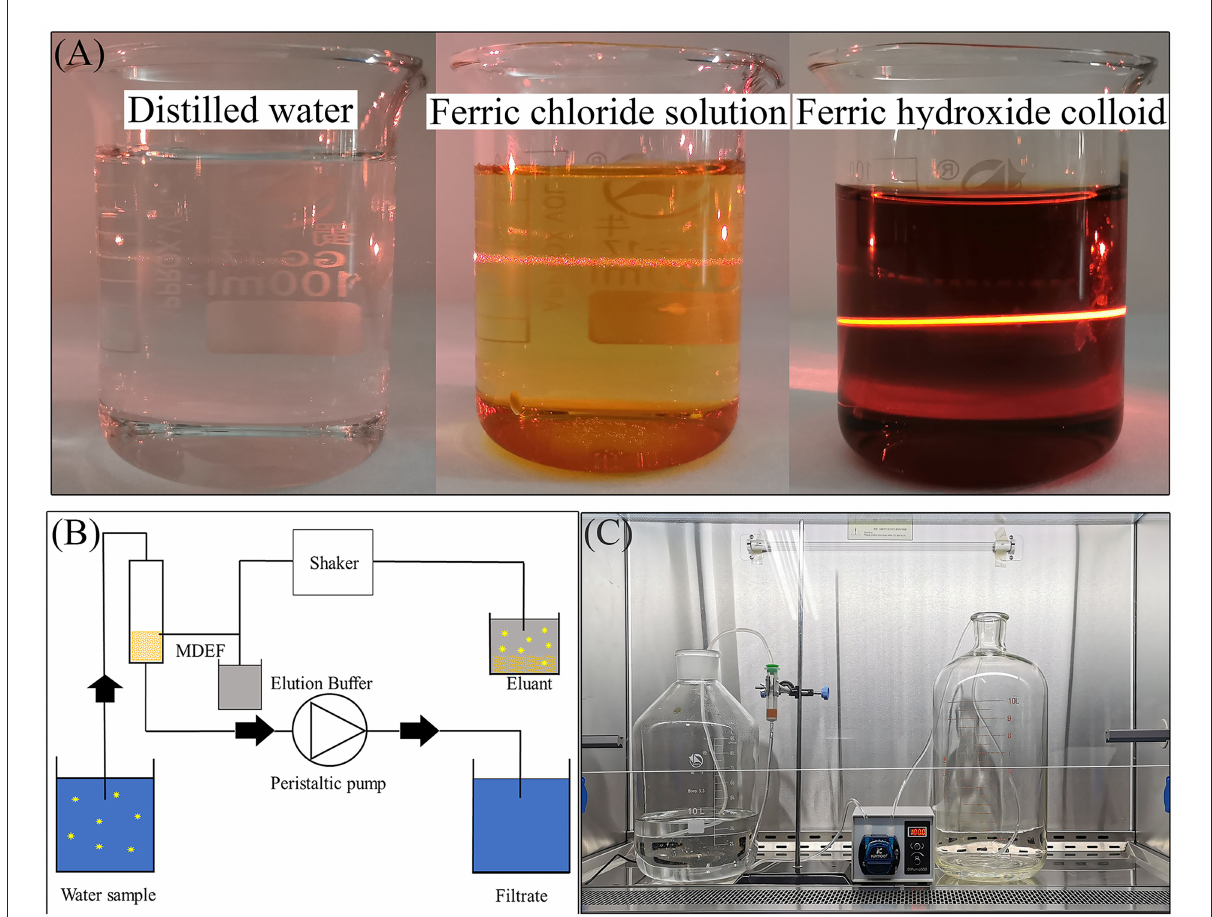
FIGURE1 A laser pen was used to irradiate three types of liquid from the side of the beaker, with the appearance of an obvious optical path in the Fe(OH) 3 colloid which was not apparent in neither the ferric chloride solution nor the distilled water (A) , schematic diagram showing the MDEF enrichment and elution procedures (B) , and the actual MDEF system (C) .